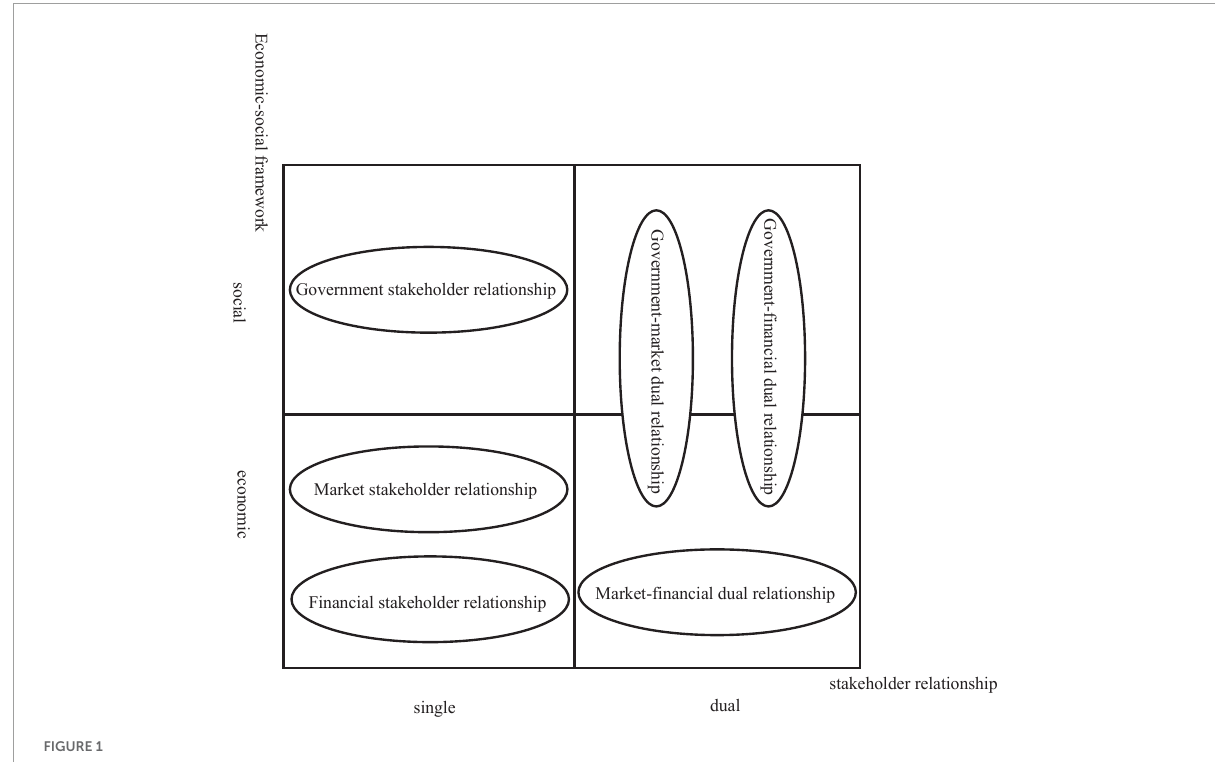
FIGURE1 Single–dual stakeholder relationship of the economic–social framework.